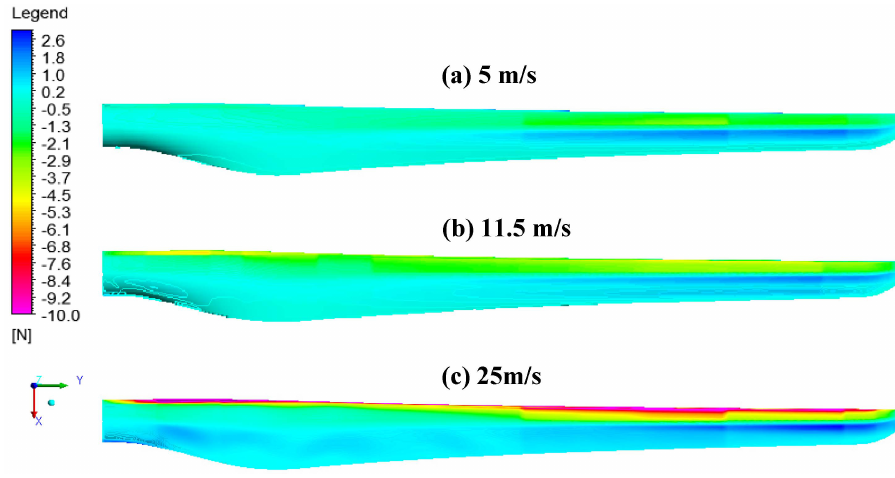
Figure 3. Fluid tangential forces contour on the suction